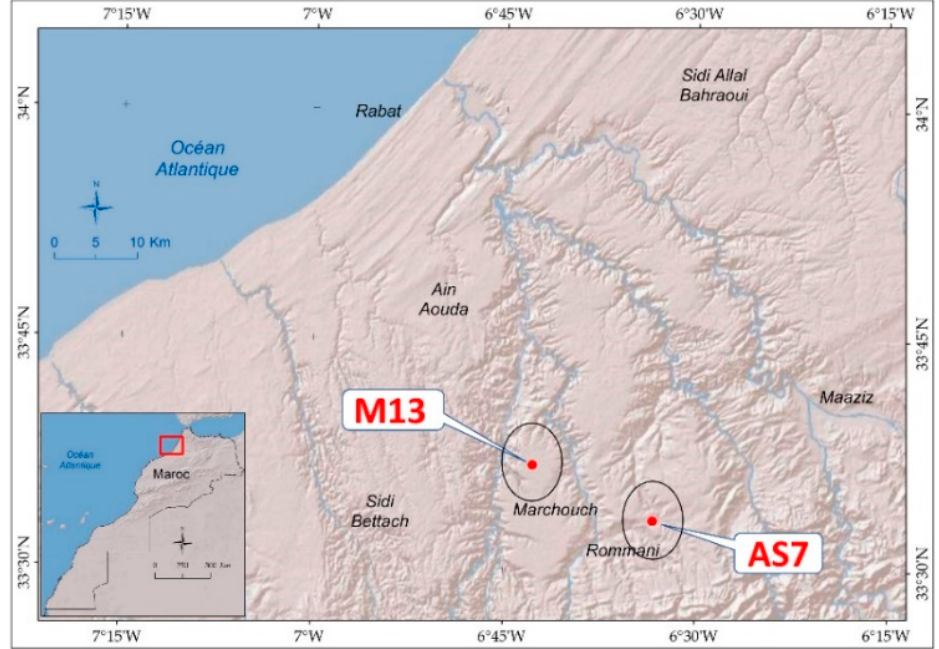
Figure 1. Location of the two study sites in the Zaer region, Morocco.